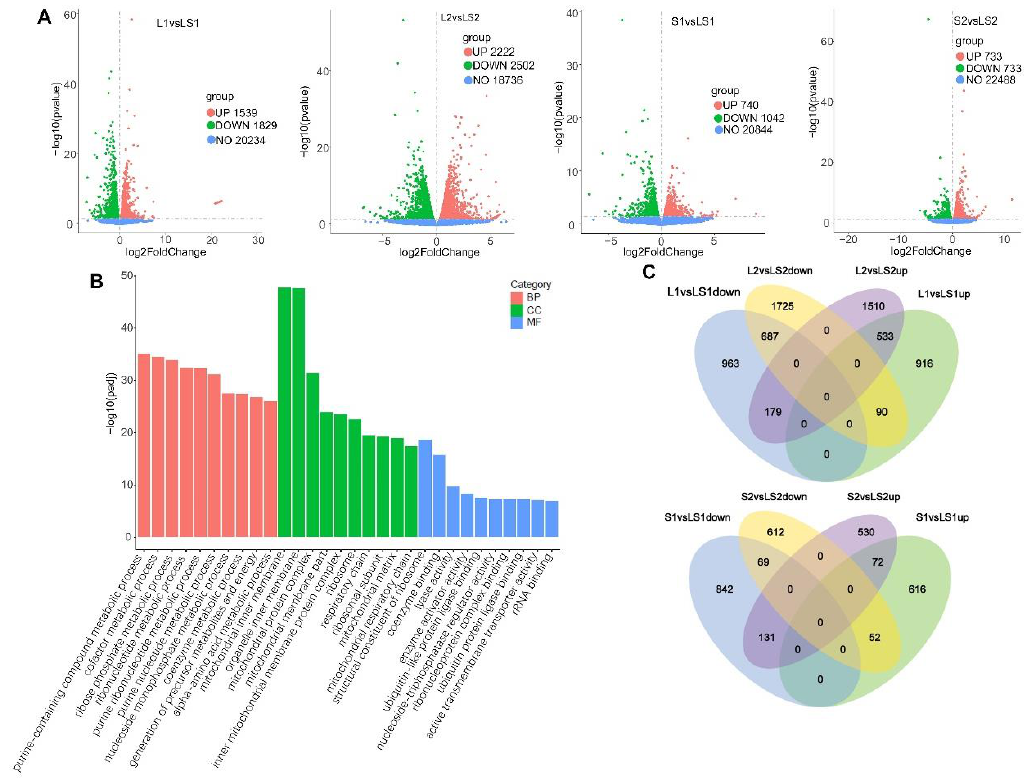
Figure 6. The liver transcriptome analysis of mice fed different oil/fat. ( A ) The volcano of DEGs; ( B ) the GO function classification of DEGs; ( C ) the Venn diagram of